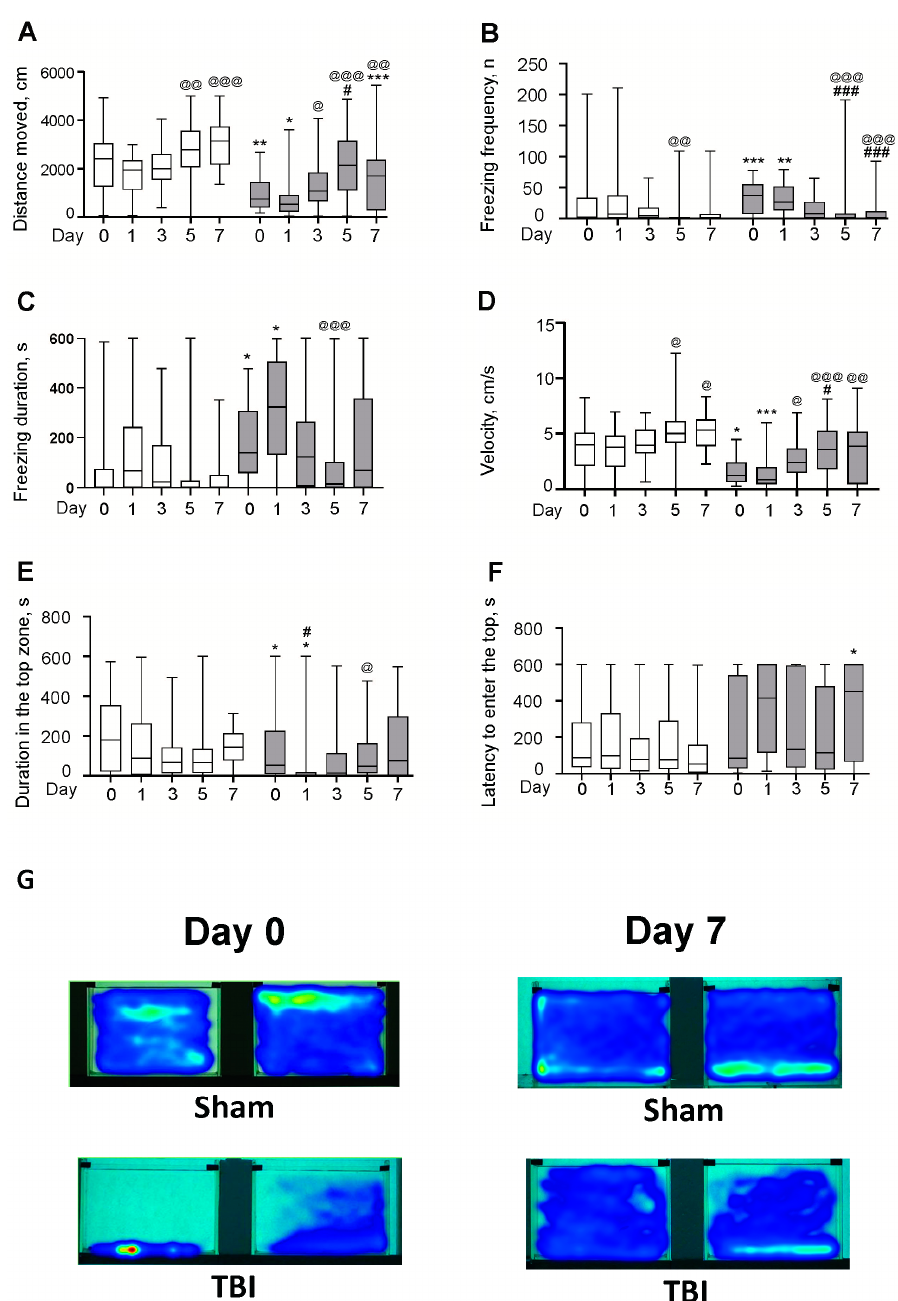
Figure 3. Effects of the laser-induced brain lesion (TBI model) on the behavior of zebrafish in the novel tank test on Days 0 (30 min after the lesion), 1, 3, 5, and 7 after the injury. General locomotion was evaluated by the distance traveled ( A ), the frequency ( B ) and the duration ( C ) of freezing, and by mean velocity ( D ). Cumulative duration in the top zone ( E ) and the latency to enter the top zone ( F ) served as indices of anxiety. White bars represent Sham groups; grey bars—TBI groups. Data are expressed as the median with first and third quartiles of the values obtained in an independent group of animals ( n = 24–36 per group). * p < 0.05, ** p < 0.01, *** p < 0.001 vs. Sham group on the same day after the injury; # p < 0.05, ### p < 0.001 vs. TBI group on Day 0; @ p < 0.05, @@ p < 0.01, @@@ p < 0.001 vs. the same group (Sham or TBI) on Day 1. ( G ) Heatmap plots integrally reflecting the position in a tank of an animal during the test for two zebrafish from each group of TBI and Sham groups on Day 0 (30 min after injury) and Day